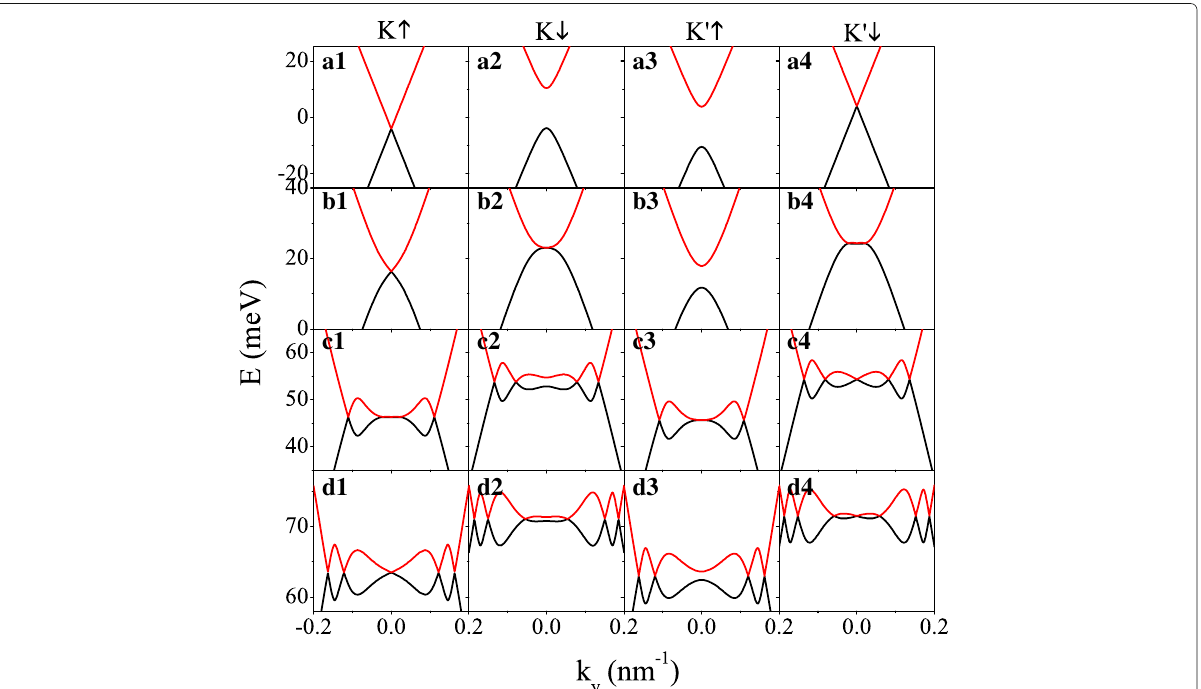
Fig. 2 Energy spectrum versus k y for several different values of potential U . (a1–a4) U = 0; (b1–b4) U = 40.66 meV; (c1–c4) U = 100.63 meV; (d1–d4) U = 135.0 meV. The values of parameters are h = 8.0 meV, (cid:2) z = 7.8 meV, and k x =